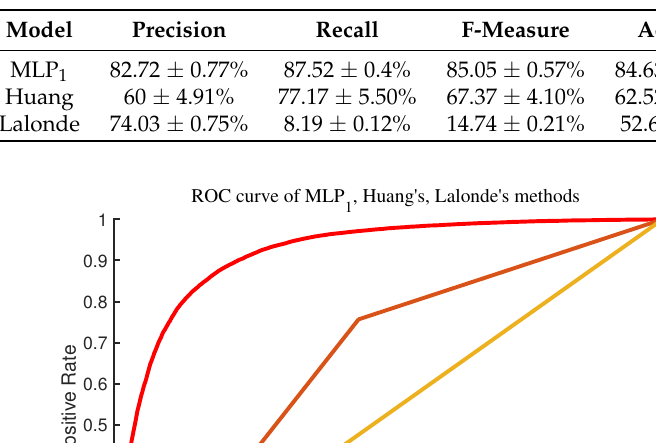
Table 2. Comparative results of our proposed shadow detection system (i.e., MLP 1 ), Huang’s and Lalonde’s methods evaluated on the test sets. All the outcomes are reported as mean value ± standard deviation.